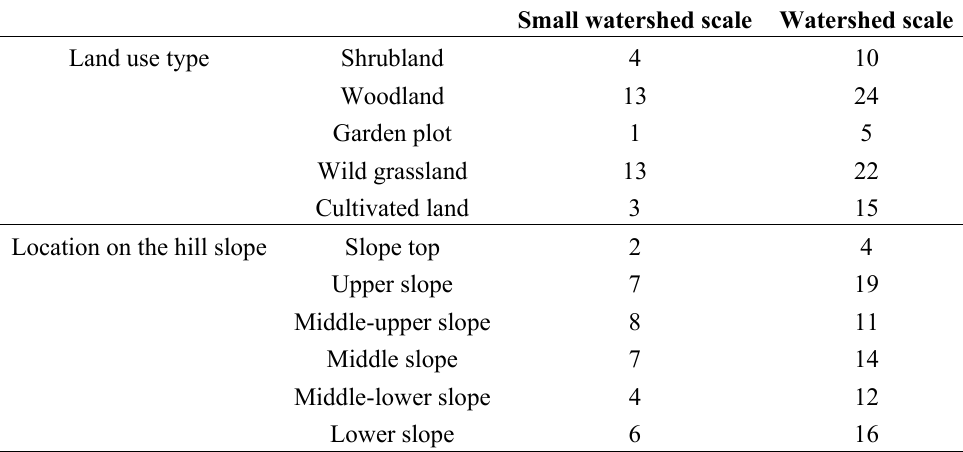
Table 1. Number of sampling sites with respect to land use type and location on the hill